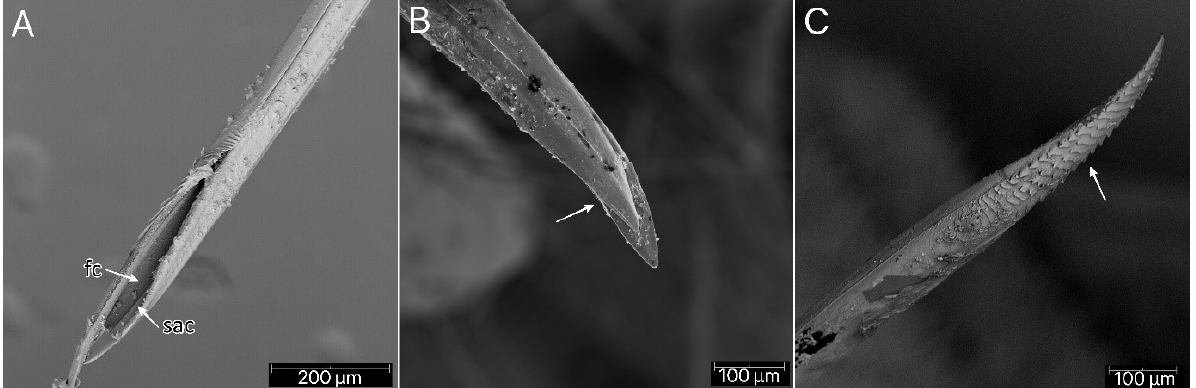
Figure 22. Psyttala horrida (Stål, 1865) fourth instar, SEM views. ( A ) Food and salivary canals of the maxillary stylets; ( B ) maxillary stylet with ridges on the interior surface; ( C ) ridges with hooklets at the apex of the mandibular stylet. fc —food canal; sac —salivary canal.